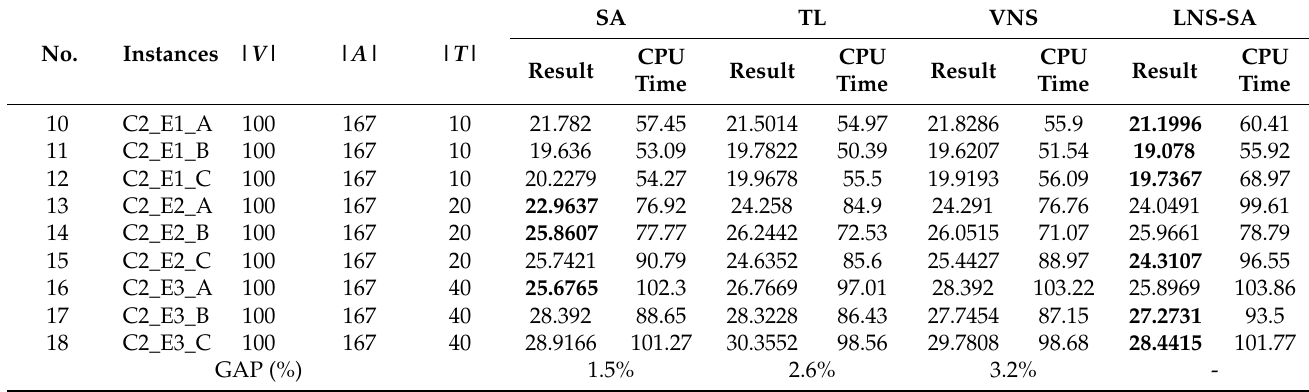
Table 5. Algorithm Performance on C2 Instances.